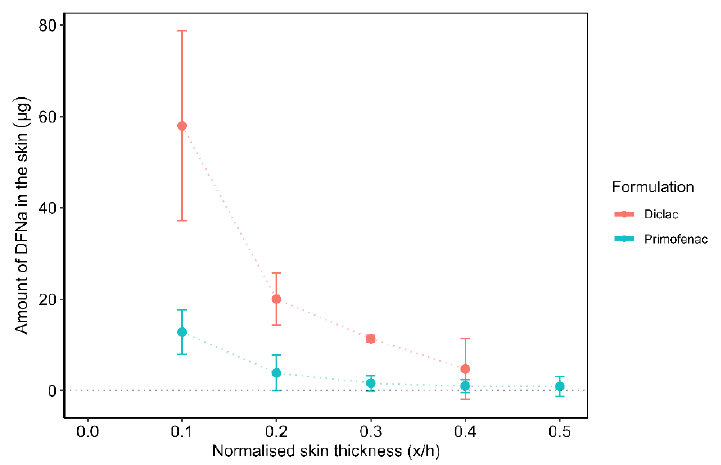
Figure 4. Amount of DFNa (µg) removed by TS across the SC following a 30 min application of formulations (mean ± SD, n = 2 subjects). formulations (mean ± SD, n = 2